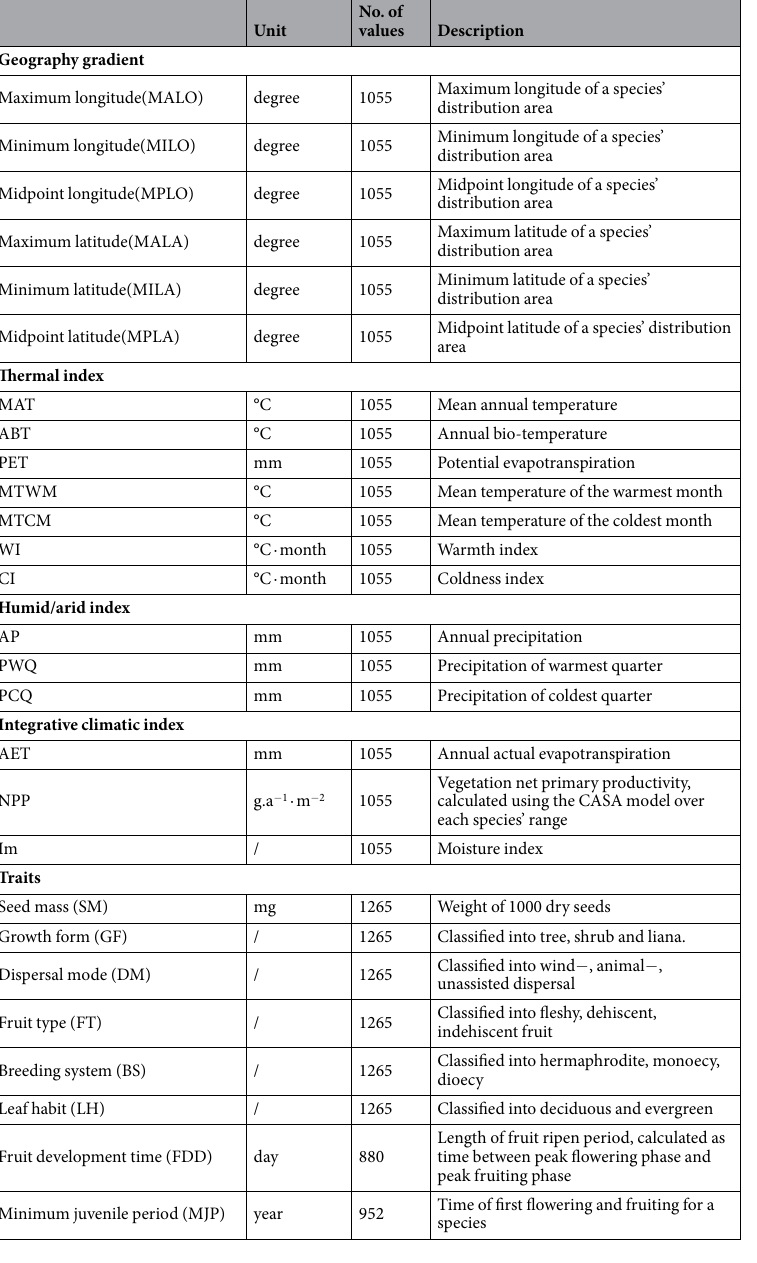
Table 1. Traits and environmental factors examined in this